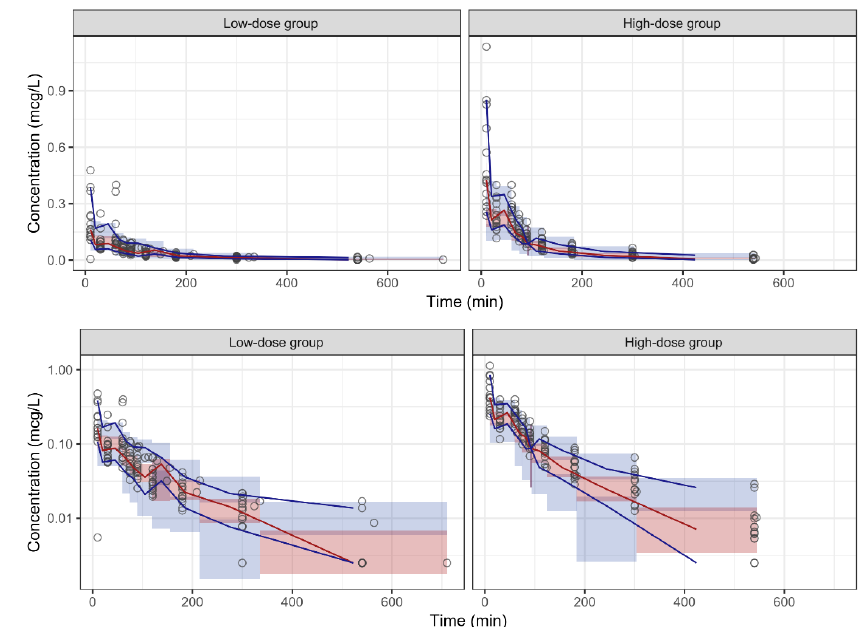
Figure 3. The linear ( upper ) and log-linear ( lower ) plots of the visual predictive check of the population pharmacokinetic model for dexmedetomidine by dose group. Circles = observed data; red solid line = median observed data; blue solid lines = 5th and 95th percentiles of the observed data; red area = 95% confidence intervals (CI) for the median simulated data; blue area = 95% CI for the 5th and 95th percentiles of the simulated